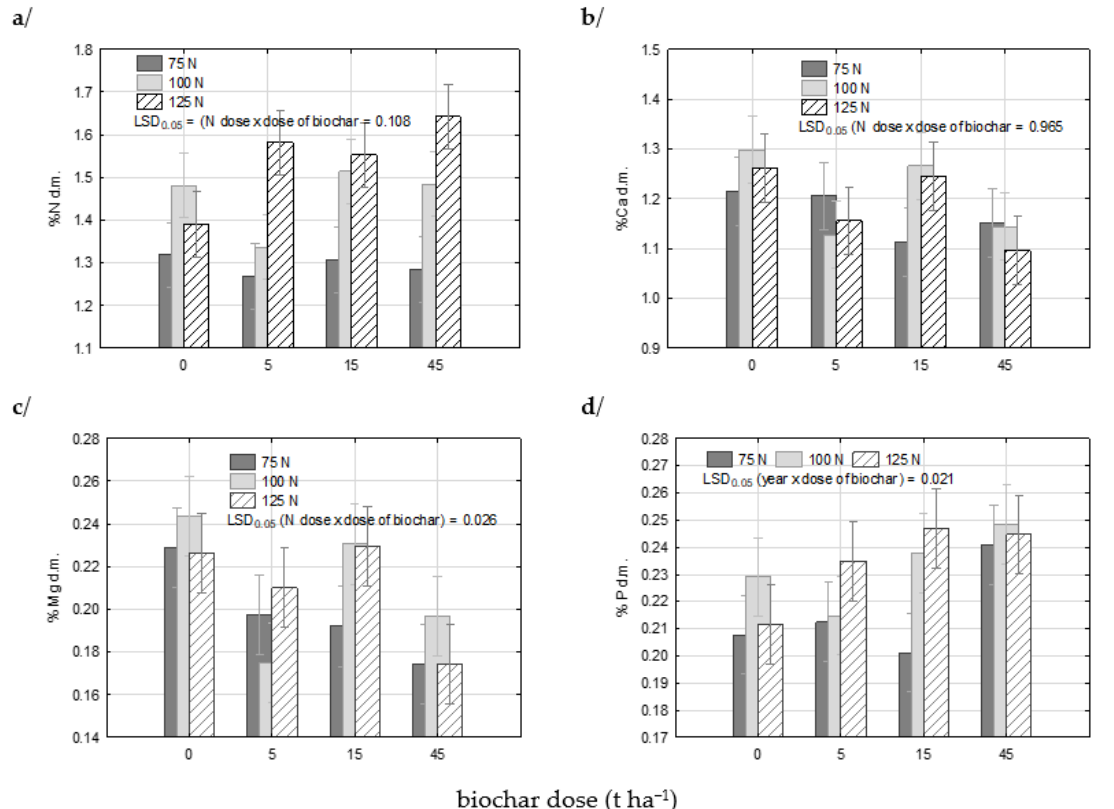
Figure 6. Content of macronutrients (%DM) and sodium (mg kg − 1 ) in mint biomass depending on the applied dose of biochar and nitrogen fertilizer (average from 2017–2019); the factors separation was achieved using NIR Fisher test p < 0.05.